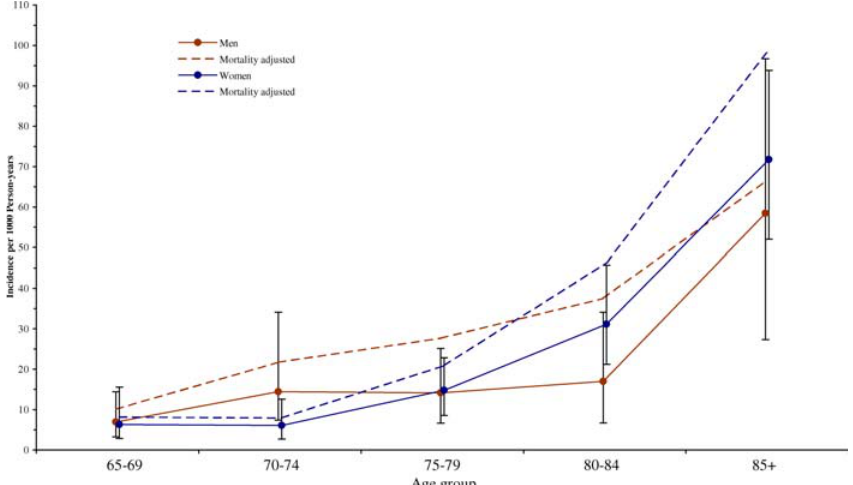
Figure 3. Incidence Rates (and 95% Confidence Intervals) by Age and Sex DOI: